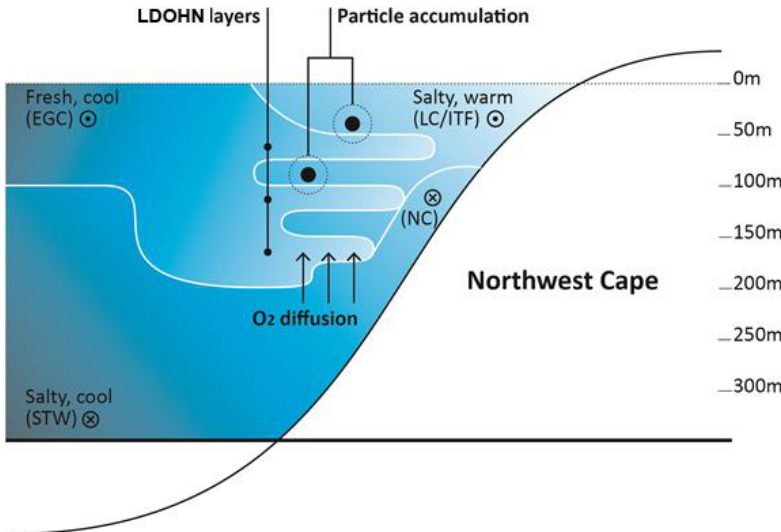
Fig. 9. Schematic of formation of LDOHN layers in the autumn off Northwest Cape, Western Australia. The fresh, cool water from the northwest (e.g. the Eastern Gyral Current, EGC) interleaves with arrival events of the more salty, warmer Leeuwin Current (LC) source waters from the Indonesian Throughflow (ITF) in the late summer and autumn. Periodically, the Ningaloo Current (NC) is formed near the coast due to strong southwesterly winds. The LDOHN layers, containing locally high nitrate and high dissolved organic carbon, as well as low oxygen and low pH, form beneath particle-rich layers sourced variously from surface waters and dependent on local surface production for supply of particles. Nitrogen fixation accounts for a measurable fraction of the nitrate generated in LDOHN waters, but seems to be rapidly transformed, taken up and remineralized, likely by